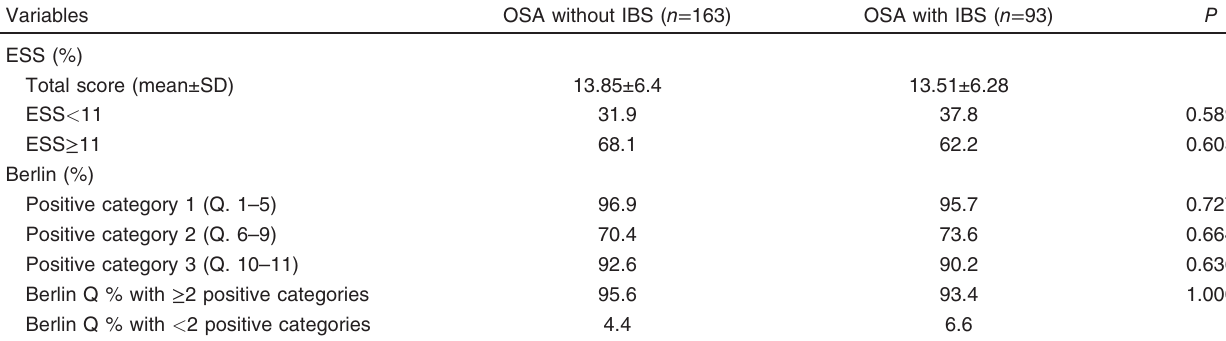
Table 1 Questionnaires in obstructive sleep apnea patient subgroups Variables